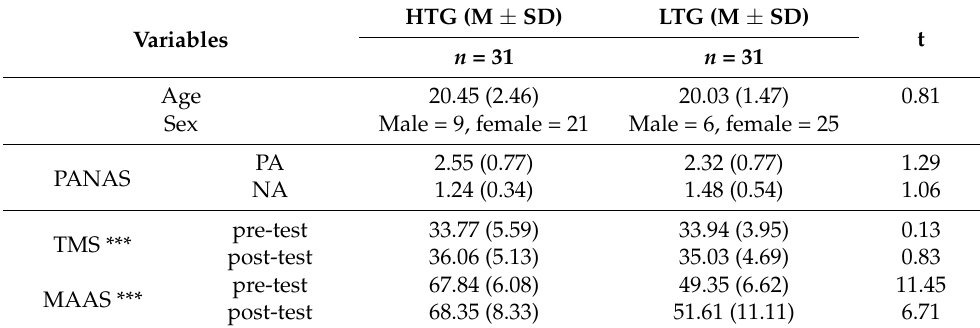
Table 1. Participants’ demographic information and self-reported results.